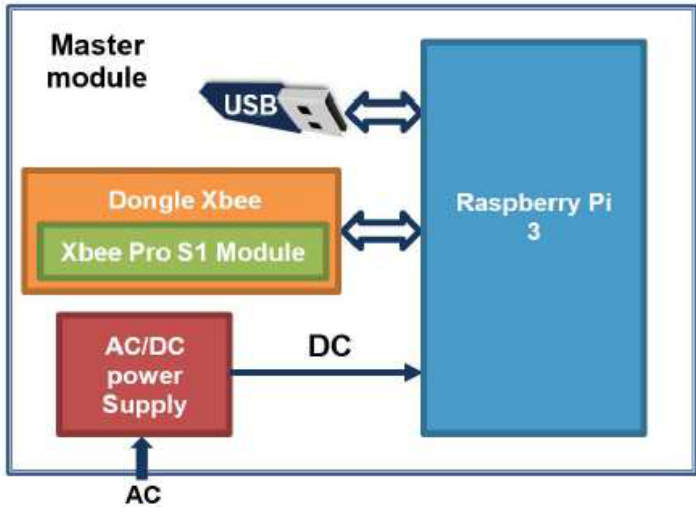
Figure 3. Master module diagram.